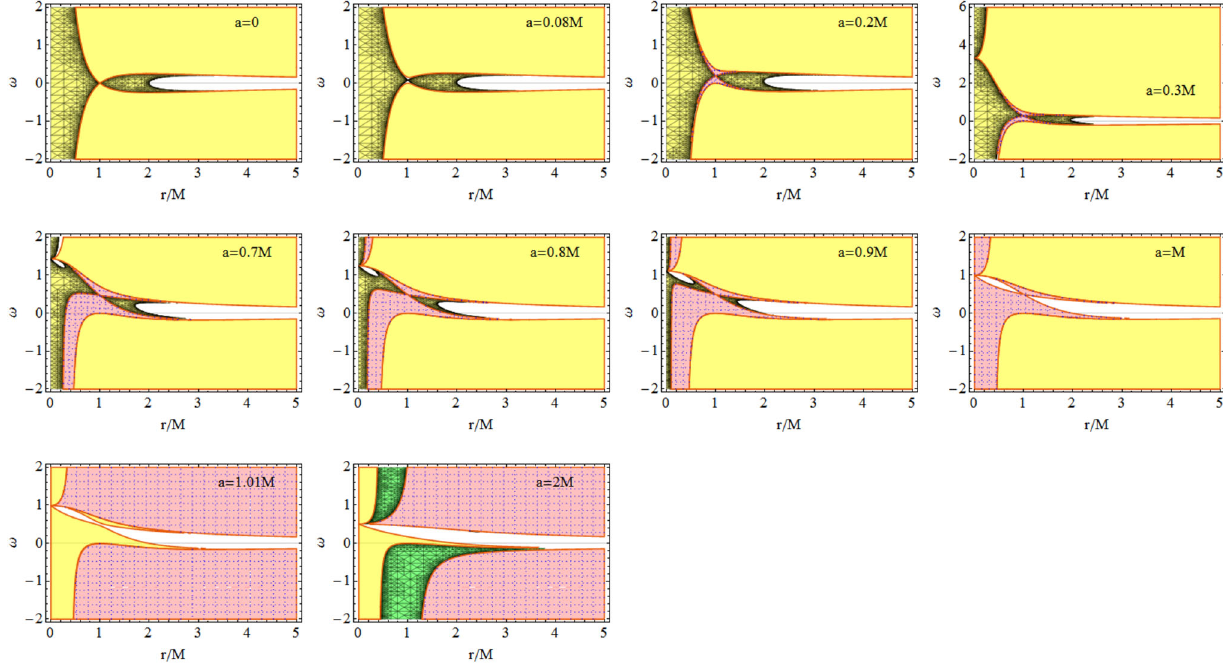
Fig. 27 Equatorial plane of the Reissner–Nordström spacetime: generalization of the analysis of Figs. 10 and 28 for the case a = 0 and Q (cid:20)= 0 tational collapses in which connections between NS and BH solutions are expected and emerge